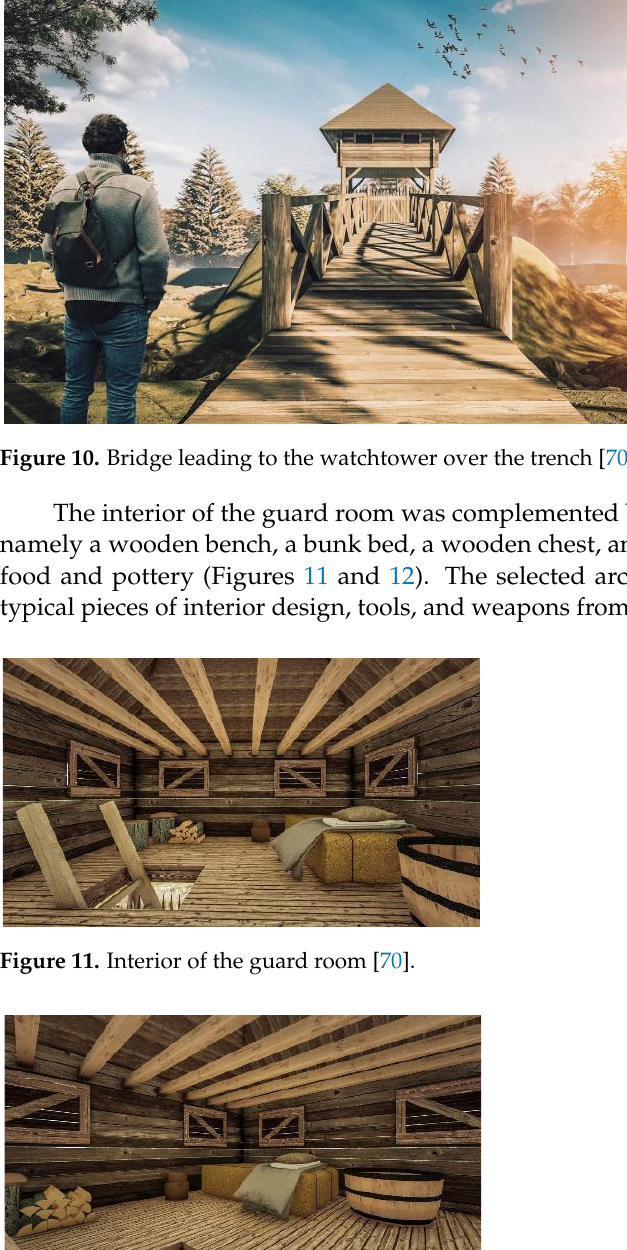
Figure 9. The 3D visualization of the watchtower [70].